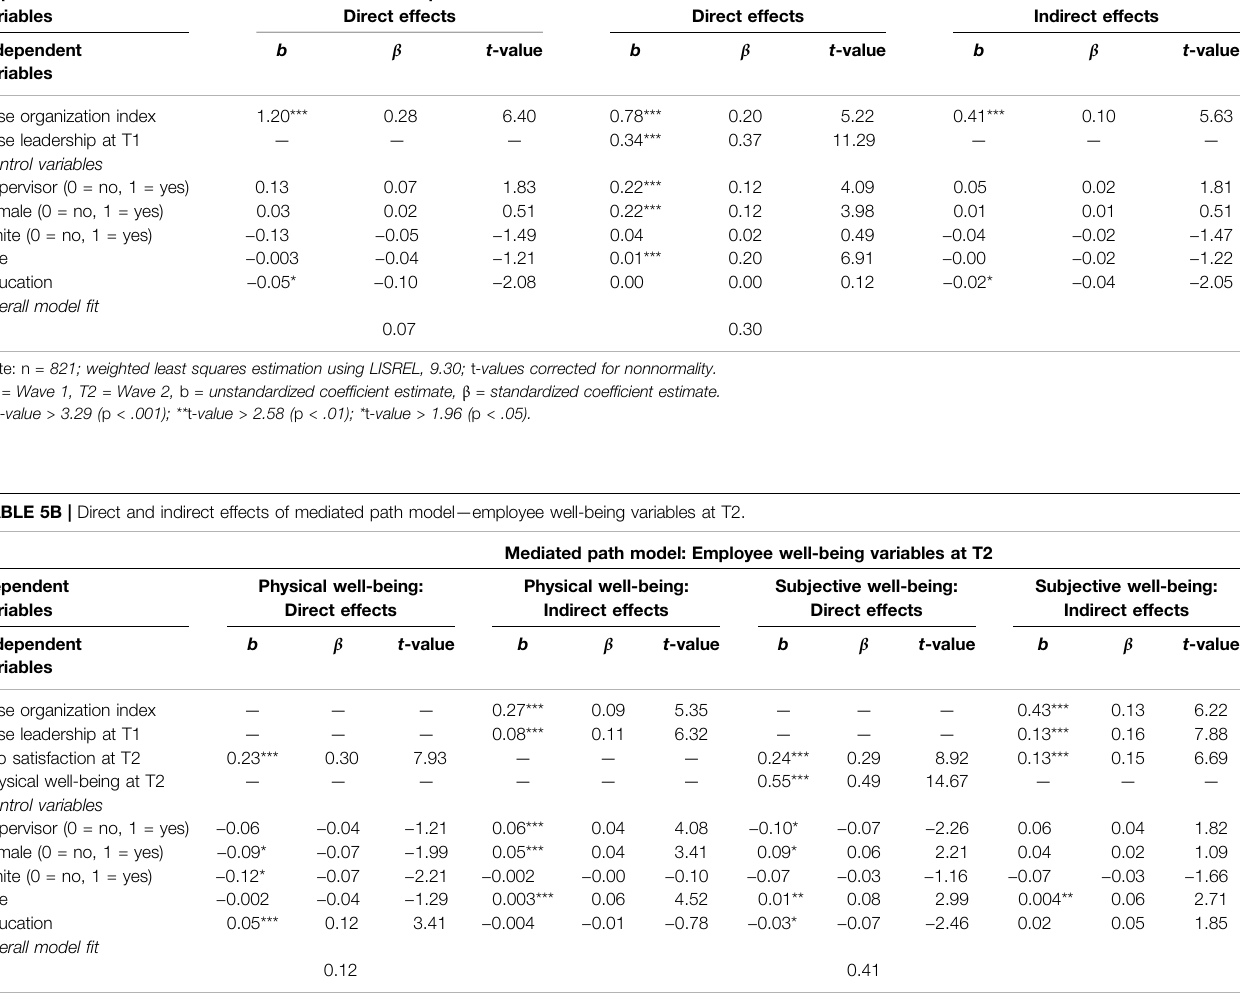
TABLE 5A | Direct and indirect effects of mediated path model — organizational variables.